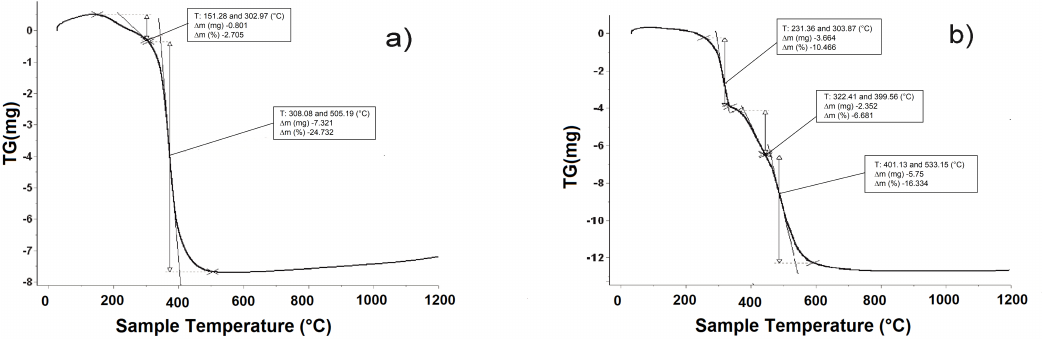
Figure 4. TG thermograms of ( a ) the NiAl nitrate LDH, ( b ) the MgAl carbonate